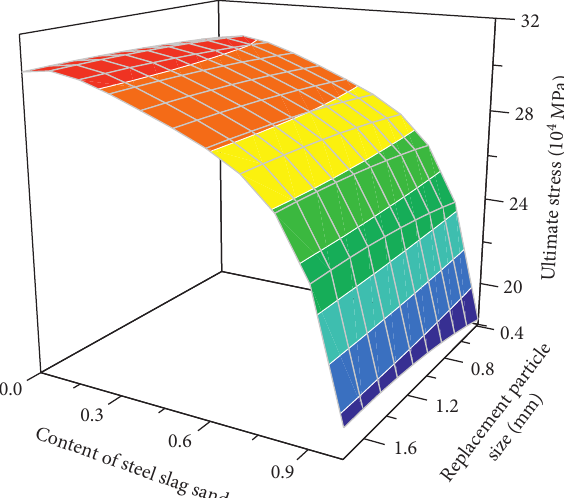
Figure 23: The impact of the content and replacement particle size of steel slag sand on the ultimate